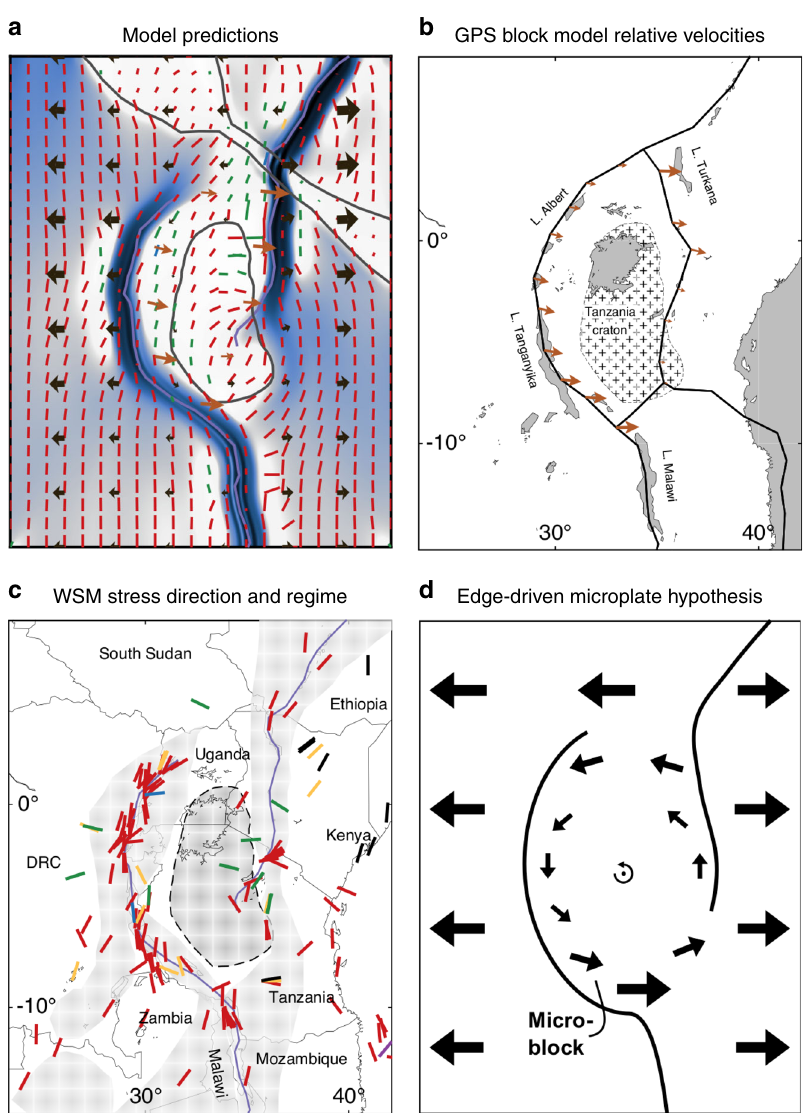
, and Fig. 8 Summary plot of East African Rift System modeling, data, and interpretation. a Results of model NS vel. craton Anza, including σ Hmax indicating in black the absolute velocity fi eld and in orange the relative motion of Victoria with respect to the Nubia plate along the Western Branch (at 100 km from the original mobile belt axis) and the relative motion of the Somalia plate w.r.t. Victoria along the eastern plate boundary (as in panel b ). b Kinematic block model prediction of Victoria microplate rotation 3 . Relative velocity vectors in orange represent the motion of the plate to the east of the plate boundary w.r.t. the plate to the west of the boundary. c σ directions from the World Stress Map 55 (WSM), including all data types and qualities, Hmax colored according to tectonic regime as in Figs. 3 – 6. Note that σ bars of the WSM have a uniform length that does not represent their magnitude. Hmax d Our schematic representation of the edge-driven Victoria microplate rotation due to transmittance of the motion of the major